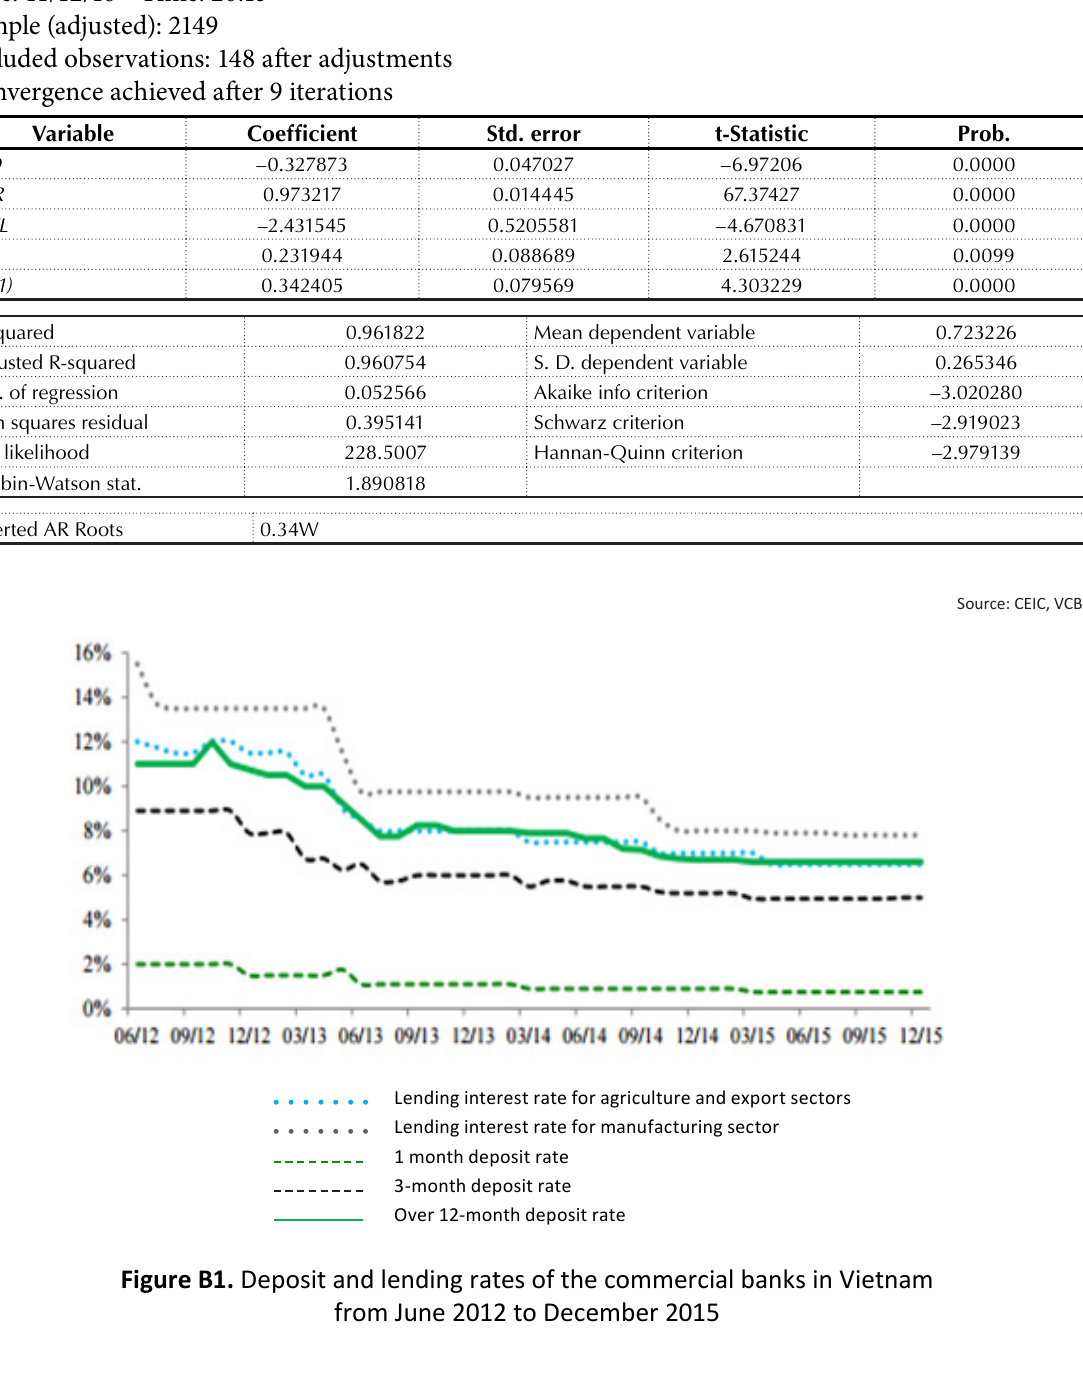
Table B8. Eviews Result 3